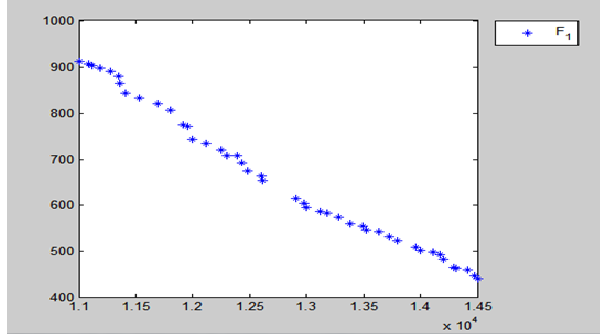
Fig. 5. The results of Pareto optimal solutions 0 307 193 0 0